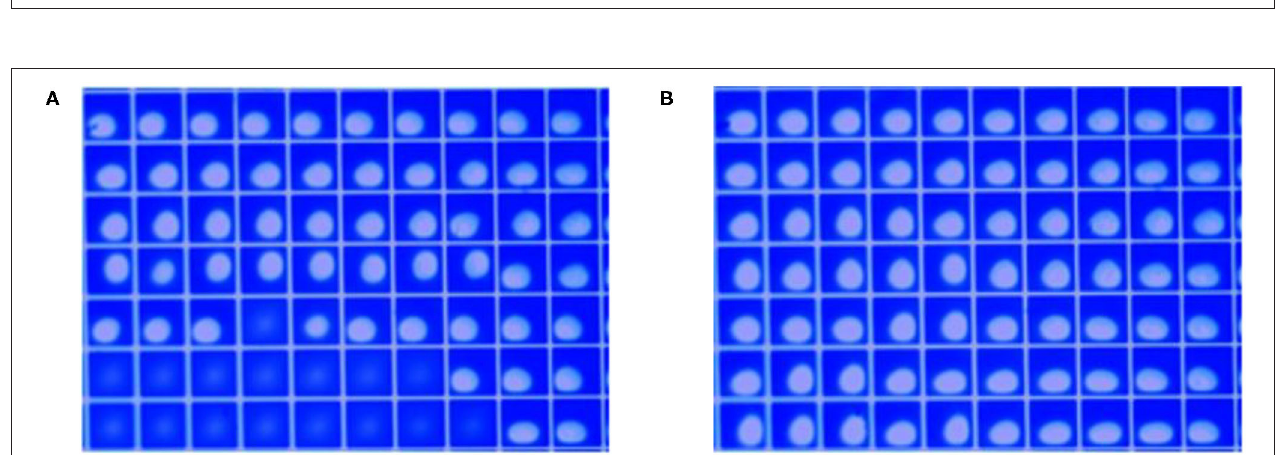
FIGURE 10 | The aperture ratio of pixels when the EWD was driven by 470Hz AC driving voltage. (A) The pixel aperture ratio was 26.50% during the voltage increasing process. (B) The pixel aperture ratio was 32.47% during the voltage decreasing process. The maximum difference was 5.97%.